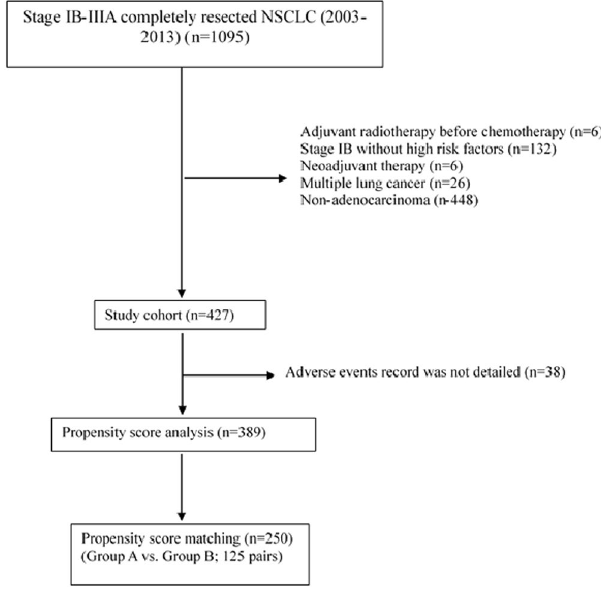
Figure 1. Flow Chart for Selection of